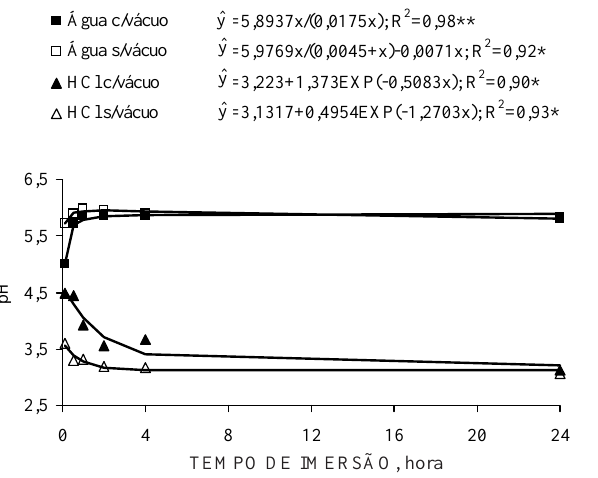
Figura 1. pH da água de imersão das cápsulas, considerando o tempo de imersão.